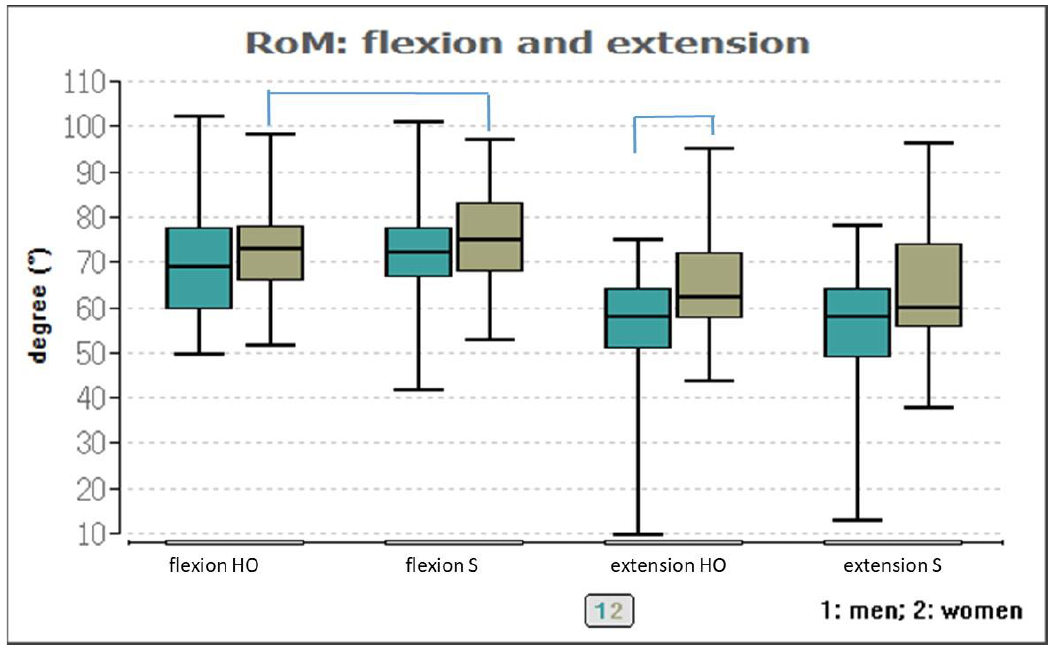
Figure 2. Range of cervical motion with either habitual occlusion or splint, separated into male and female subjects.